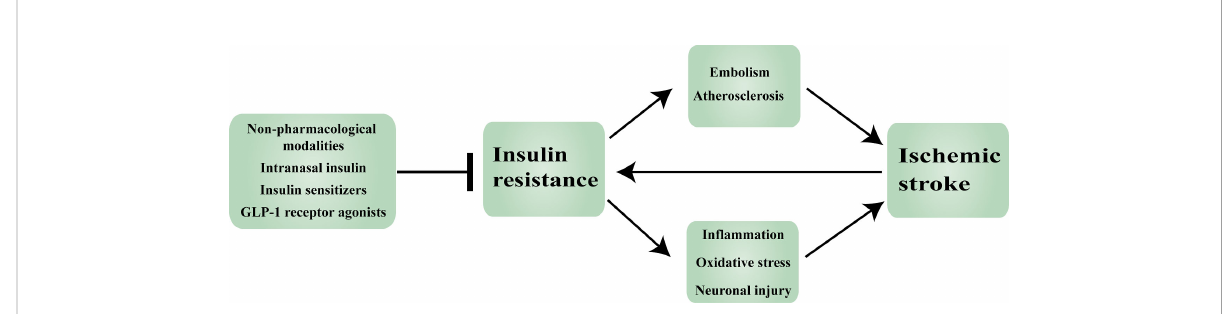
FIGURE 3 Insulin resistance in ischemic stroke: mechanisms and therapeutic approaches. GLP-1: Glucagon-like